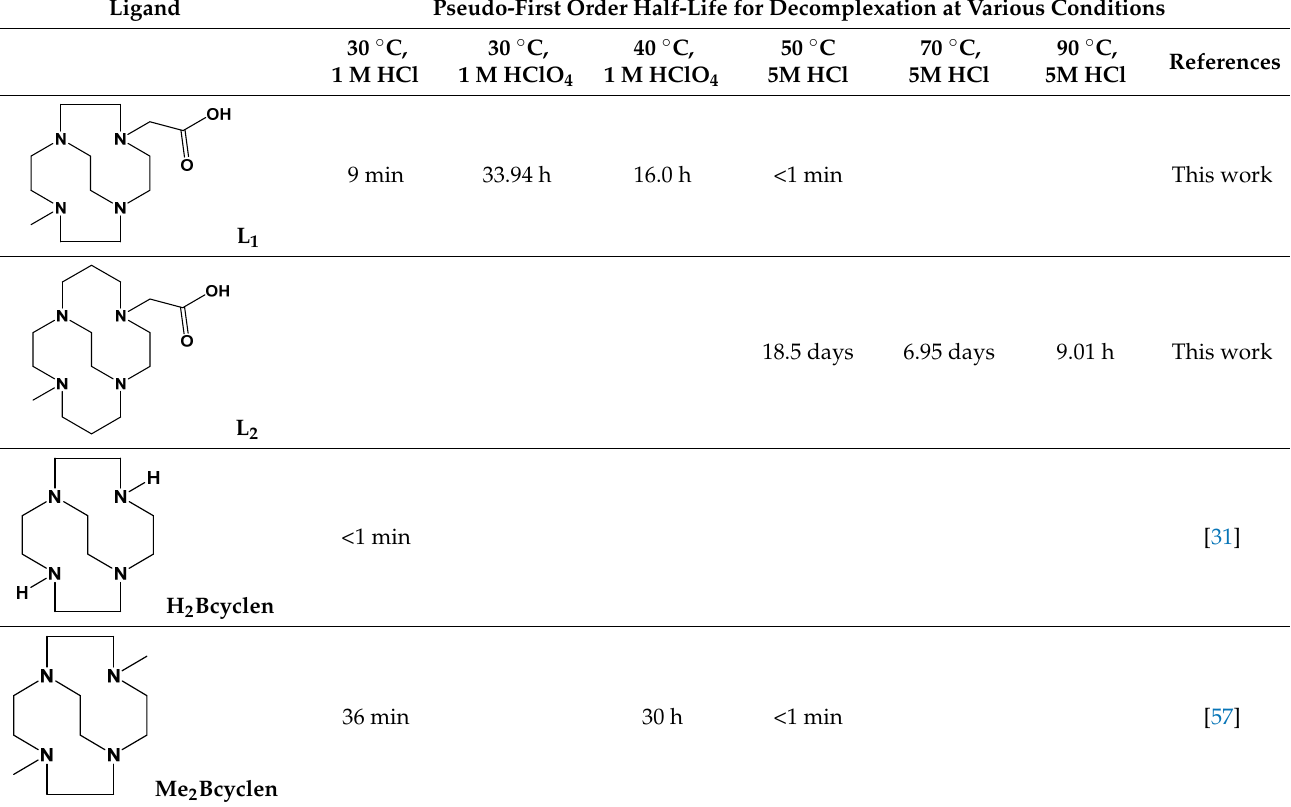
Table 3 . Half-life values for selected copper complexes in an acid environment. Ligand Pseudo-First Order Half-Life for Decomplexation at Various Conditions